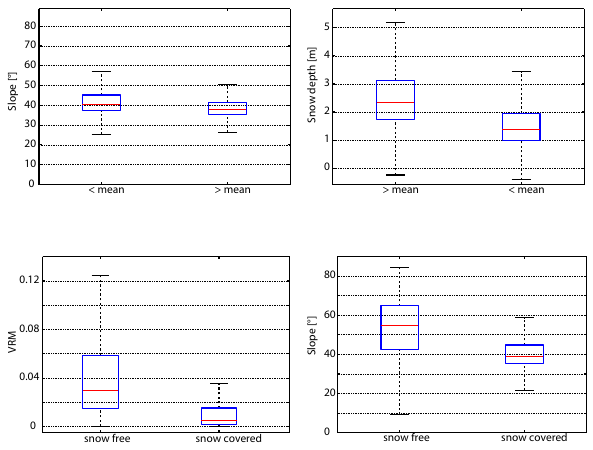
Fig. 10. Top: Box plots to compare slope angle (left plot) and snow depth at the end of the accumulation season (HS max , right plot) of cells with a snow depth change (dHS) higher ( > mean) or lower ( < mean) than the mean. dHS is given for period 7, ranging from 31 March to 15 April 2009. Bottom: Box plots to compare surface roughness (VRM, left plot) and slope angle (right plot) of snow free or snow covered cells in the rock face Ch¨upfenflue. The snow cover is estimated based on the orthophoto from 27 March 2009 (end of the accumulation